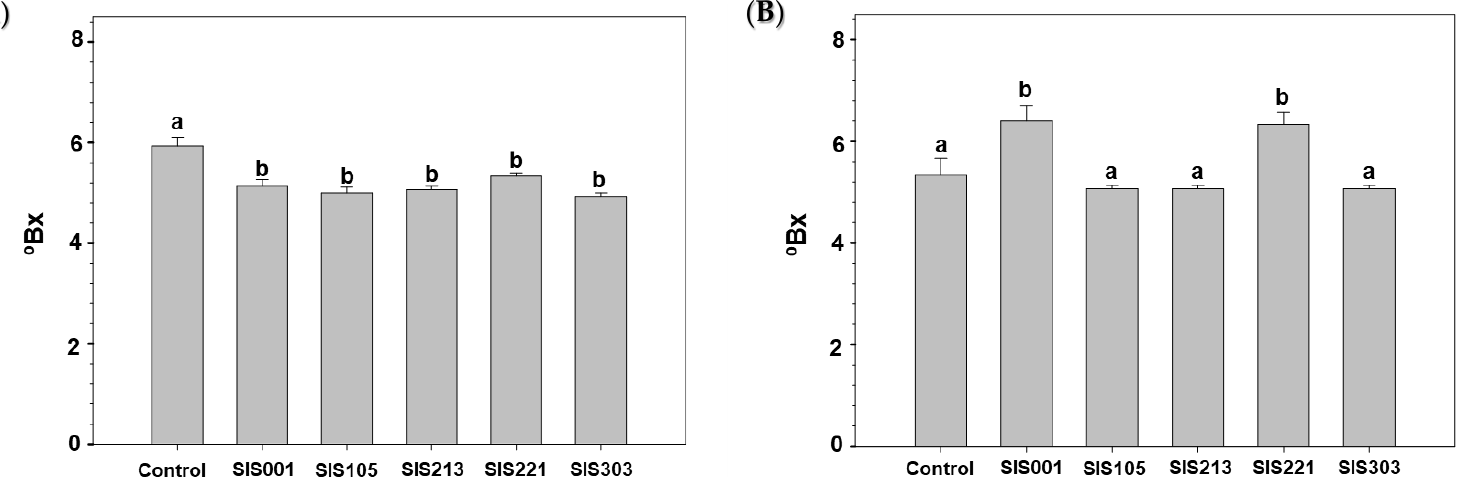
Figure 4. Effect of rhizobacteria inoculation on degrees Brix of ( A ) Tres Cantos and ( B ) cherry plants. The levels of sugars in terms of degrees Brix (°Bx) were measured in juice from tomato fruits after harvesting. Data are the means ± SE of 3 replicates. Values marked with different letters within each panel are significantly different according to Duncan’s multiple range test, p < 0 . 05.